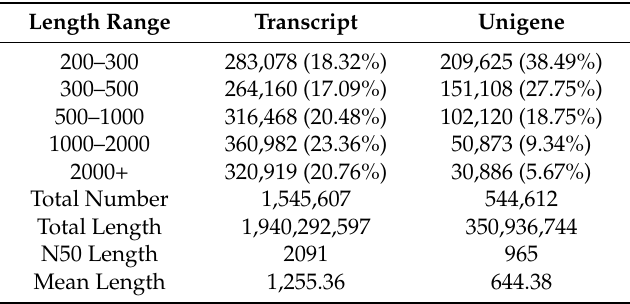
Table 2. Summary of the assembled transcripts and unigenes.